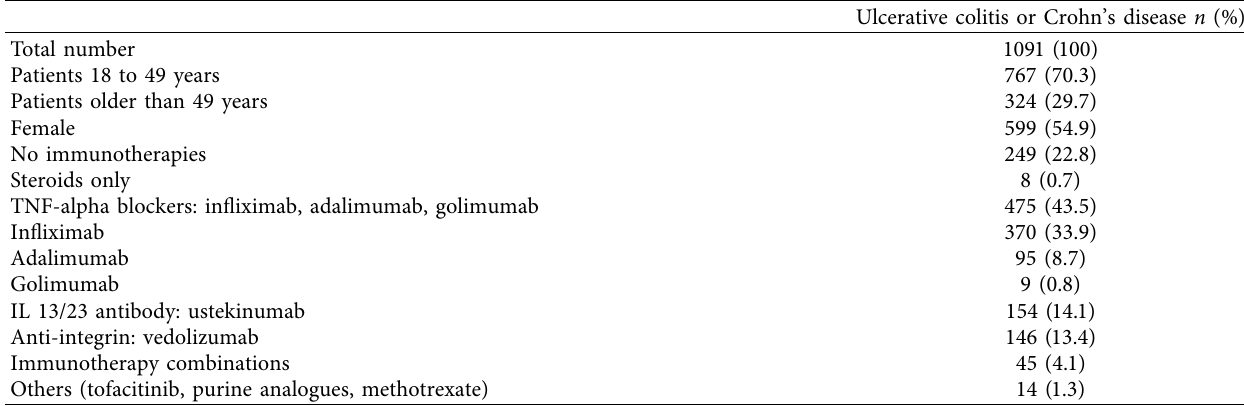
Table 1: Characteristics of the IBD